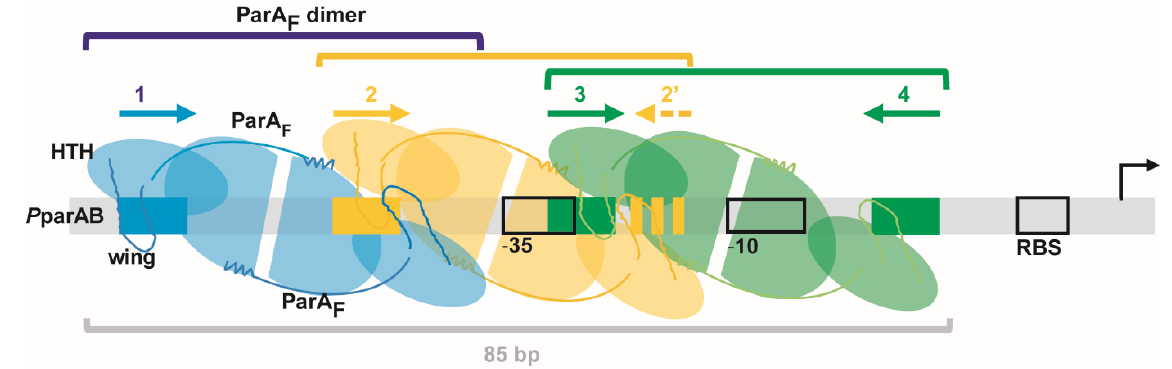
Figure 6. Model of ParA cooperative binding to plasmid partition promoters. Schematic representation of three ParA dimers bound over the P parAB promoter region. DNA is represented by a grey bar with the ParA binding motifs displayed by rectangular boxes and arrows colored according to Figure 5C. Each ParA monomer is represented by a semi-oval (Walker-box domain) link to an oval (Nter domain) with the same color-code as their respective binding motifs. ParA are dimers in the apo and ADP-bound forms that are stabilized by the first Nter α -helices (represented by curved lines ending by a zigzag), which maintained the two monomers together. The wHTH motifs, symbolized by the ovals with loops (drawn with darker lines) emanating from them, contact specifically the DNA binding motifs. A ParA dimer (green) binds, through the two symmetrically oriented wHTHs, to an inverted repeat motif composed of two perfect binding sites spaced by 28-bp (for F, IR3-4). This initial binding enables the cooperative loading of a second ParA dimer (orange) on imperfect IR motif (IR2-2 ′ ) composed of a slightly degenerated motif #2 ′ in reverse orientation and spaced by 27-bp relatively to the motif #2, and of a third dimer (blue) on an imperfect IR motif (for F, composed of only 1 perfect binding site (#1)). We propose that these two secondary bindings are mediated by dimer − dimer contacts through the wings of two intertwined dimers, resulting in a stable complex composed of three dimers bound to the promoter region. The flexible wHTH allows each monomer to contact one hexamer motif by adapting to the local DNA constraint and to interact with an adjacent dimer bound to the overlapping binding motifs through the wing. The overall complex assembled on the promoter region covers ~85-bp. For simplicity, the schematic is drawn with a straight representation and not with bent DNA. ParB may increase ParA binding affinity by enabling an extended conformation proficient for the assembly of a stable complex without interacting directly on the